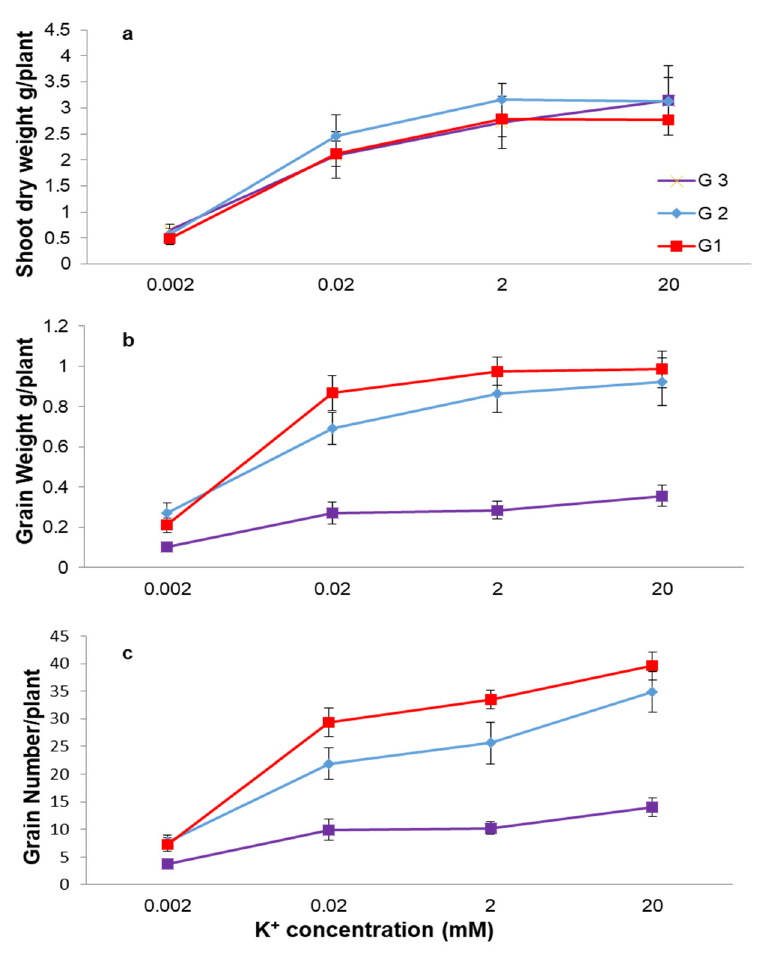
Figure 2. Comparison of the groups produced by cluster analysis, showing the differences in mean values between groups in ( a ) shoot dry weight ( b ) grain weight and ( c ) grain number at different K +